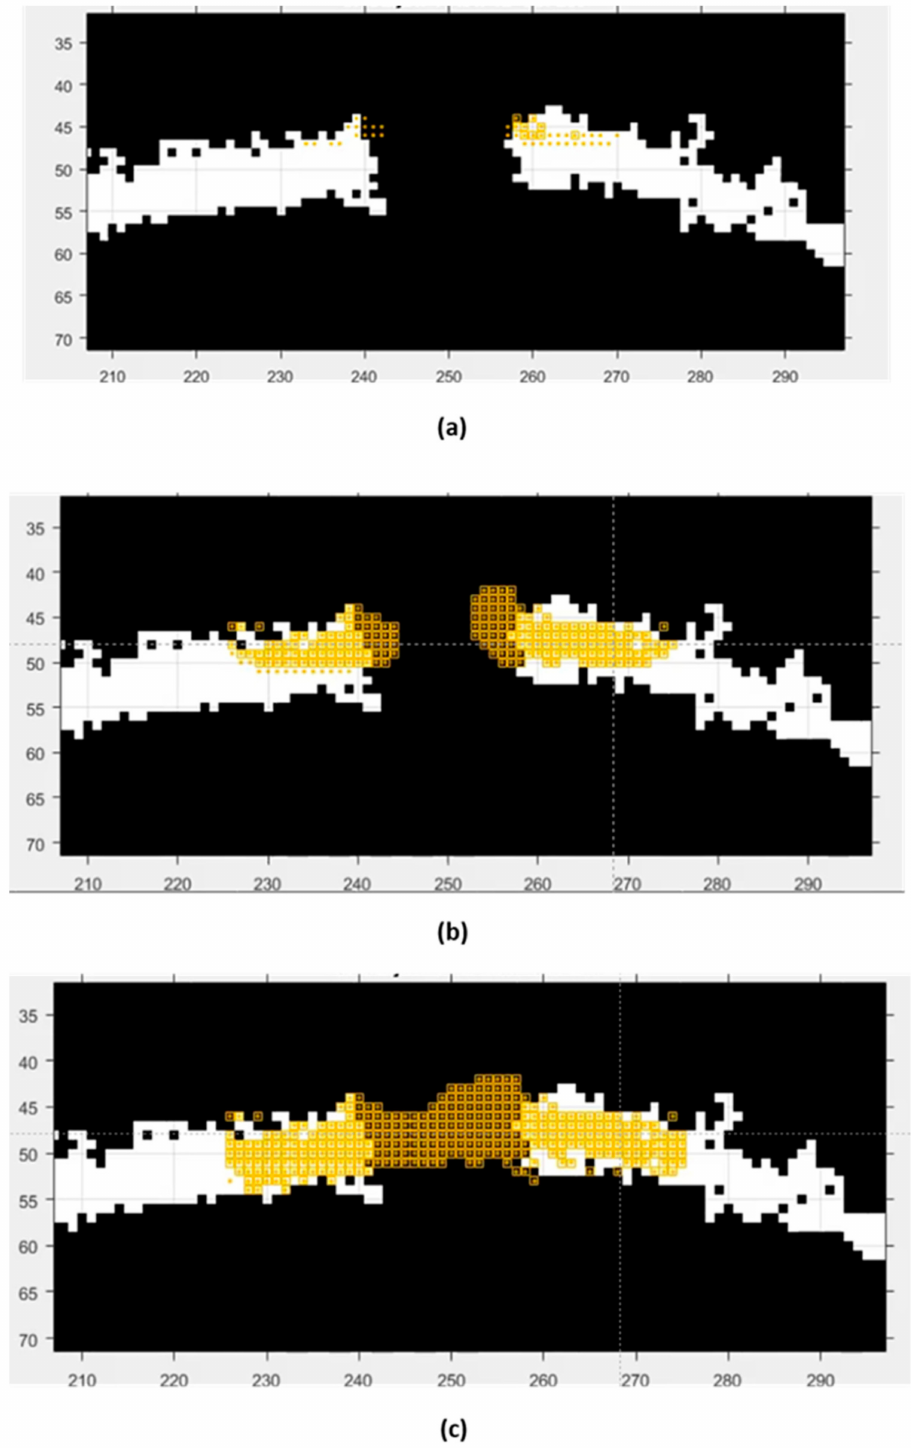
Figure 11. ( a – c ) Three instances captured in-process where Mahalanobis Distance was used to identify points on road under